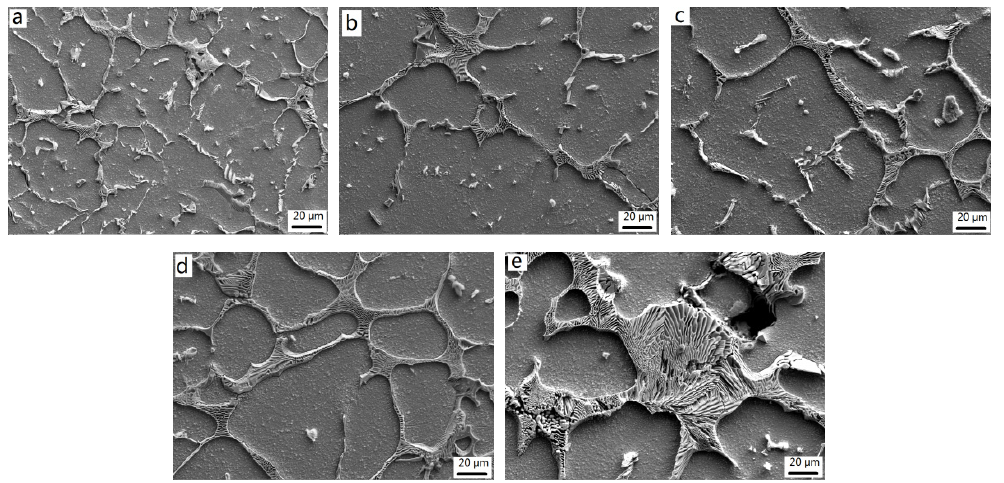
Figure 9. Distribution of carbides in the different samples from the continuous casting billet ( a – e ×500 for the billet from edge to center).